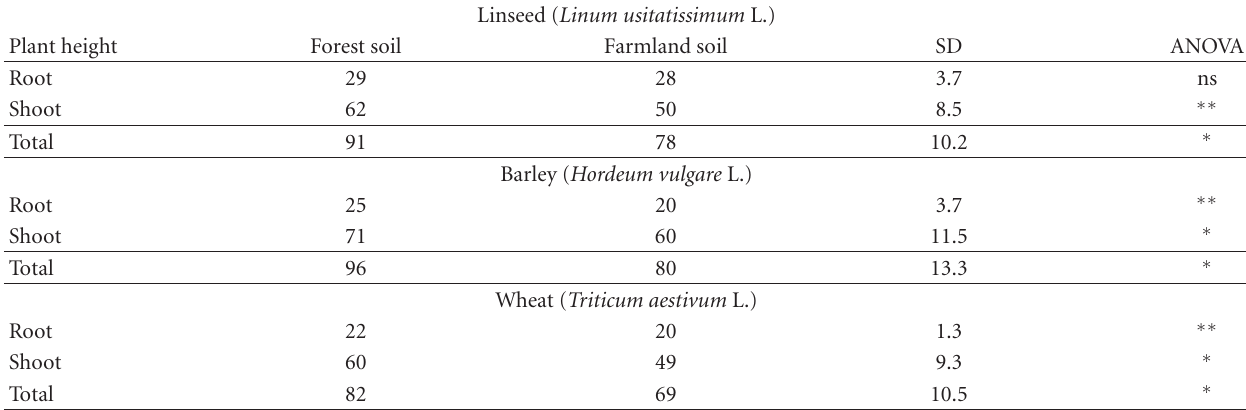
Table 2: Whole plant height (cm) of indicator